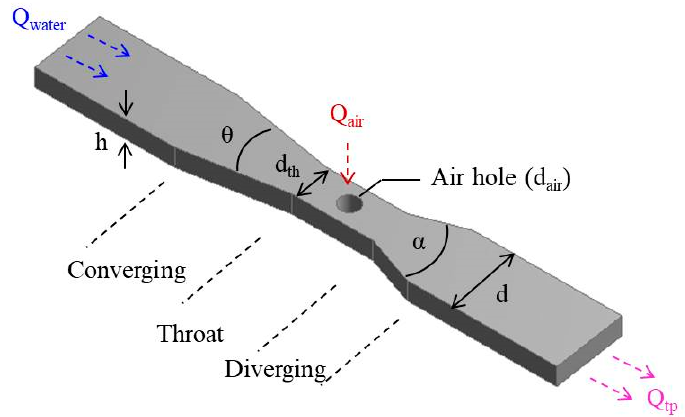
Figure 1. Schematic of the self-entrainment venturi nozzle with an air hole. The nozzles are made of transparent acrylic to visualize water–air two-phase flows caused by air entrainment. The images are collected using a CCD camera (VEOE-310L) at 1000 frames per second, and to capture the frozen images of bubbles, the exposure time of the CCD camera is reduced to 2 µ s by controlling the shutter speed. Figure 2 shows the experimental setup and data acquisition devices for the self-entrainment